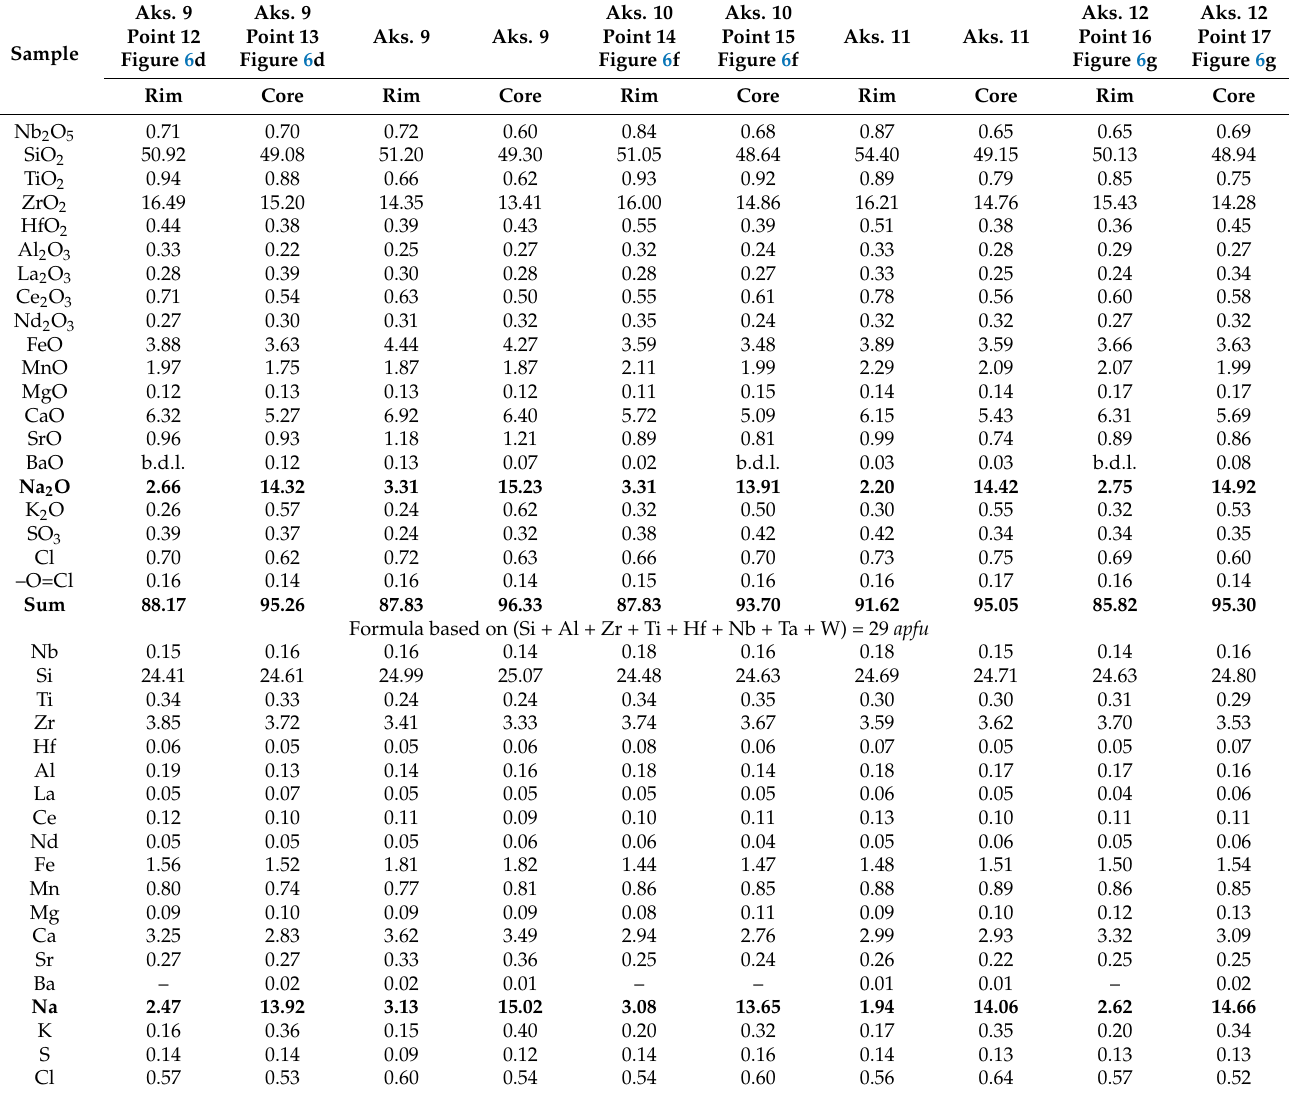
Table 5. Representative chemical analyses of EGM after experiments with 0.1 mol/L HCl solution